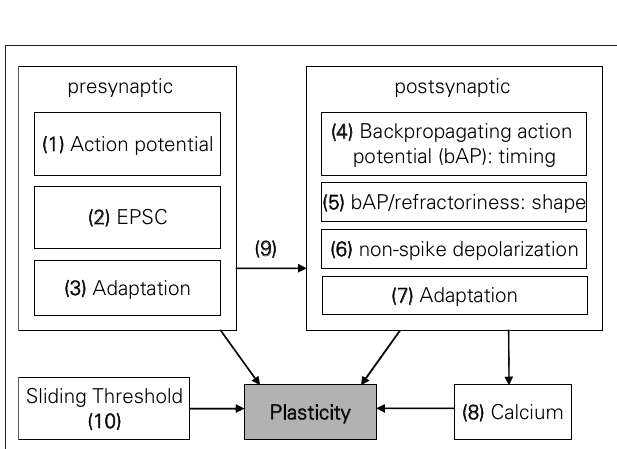
FigurE 2 | Overview of mechanisms commonly included in plasticity models. The numbers are used in the taxonomy of the models in Table 3 . A standard STDP (Song et al., 2000; Froemke et al., 2006) that computes the change in plasticity directly from the relative timing of pre- and postsynaptic spikes would be denoted by (1, 4). Some kind of presynaptic influence on the postsynaptic side (e.g., if a PSC raises the postsynaptic potential) is denoted by 9, a metaplastic sliding threshold by 10,